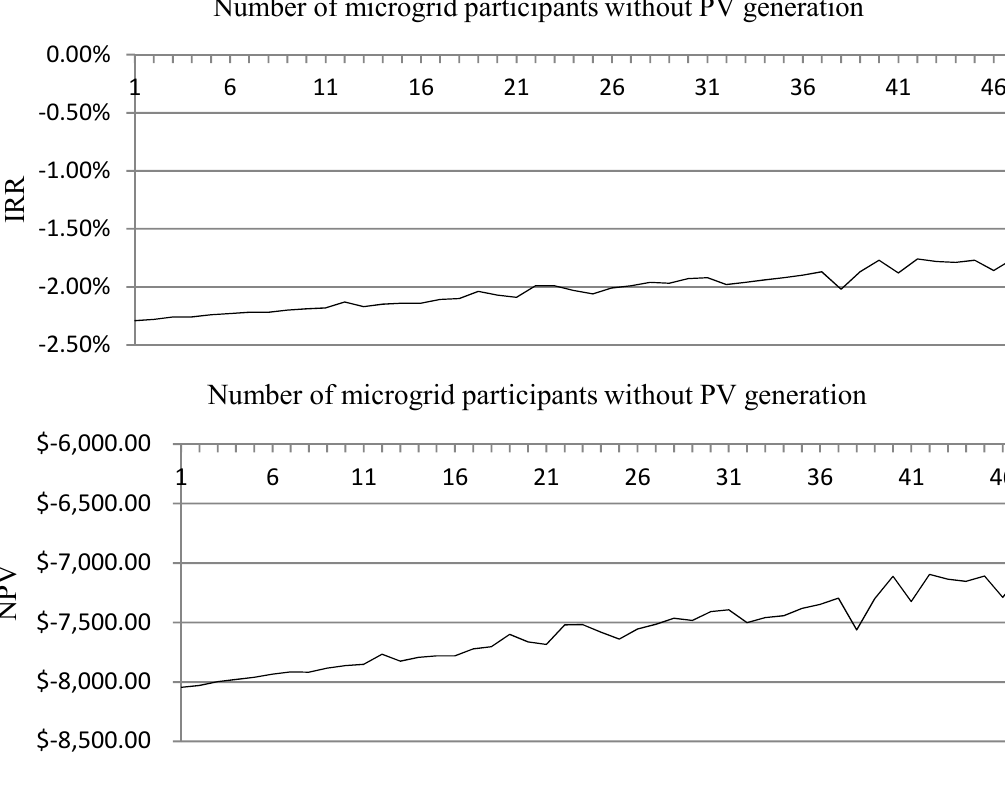
Figure 7. NPV and IRR for fifty arrangements of the proposed